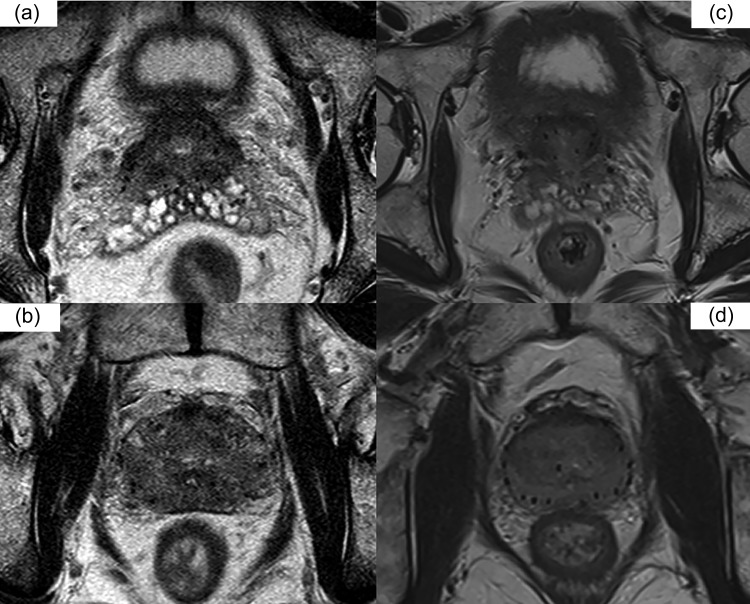
Comparison of the images obtained with 1.5-T magnetic resonance imaging (MRI) and 3.0-T MRI systems. (a, b) 1.5 tesla MRI, (c, d) 3.0 tesla MRI.